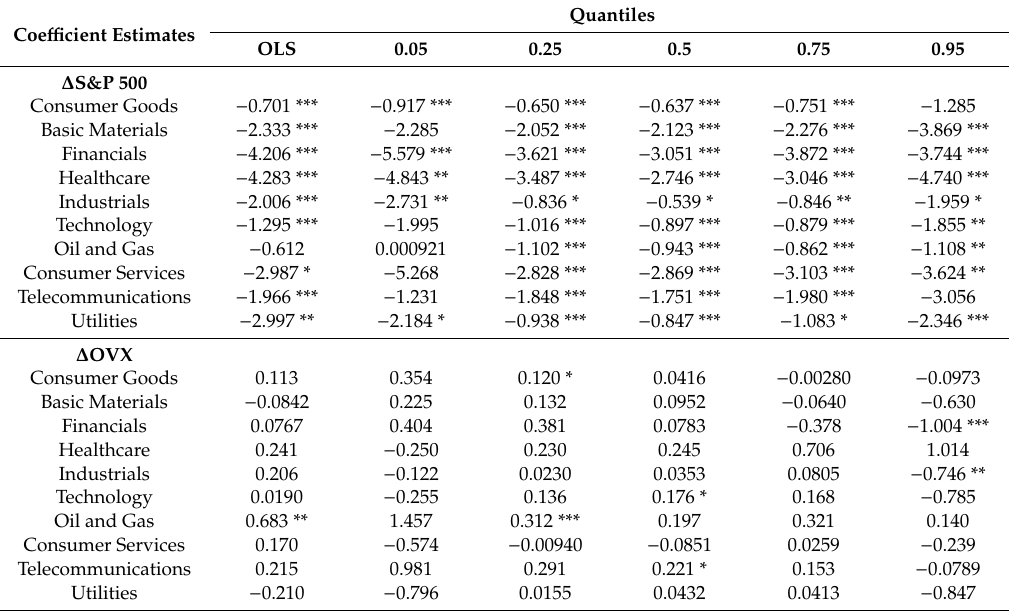
Table 5. Quantile regression estimates of macroeconomic risk factors for U.S. industrial